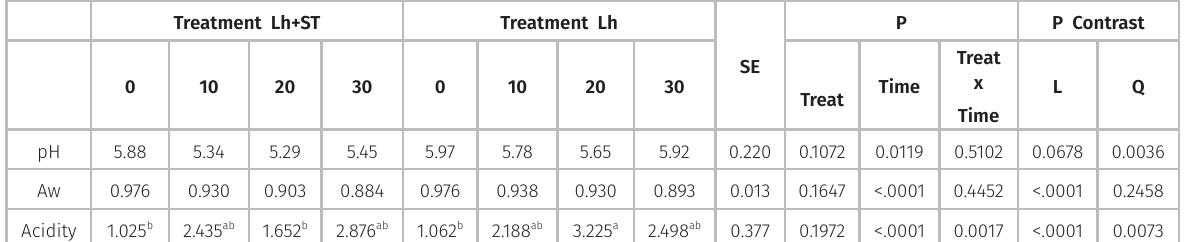
Table IV. Physico-chemical composition of ripened cheese. Treatment Lh+ST Treatment